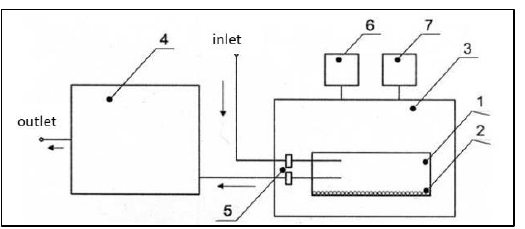
Fig. 2. Diagram of a system for assessing the toxicity of gas mixtures using the BAT-CELL Bio-Ambient-Tests method (1 – sterile sampler, 2 – cell line devoid of culture fluid, 3 – conditioning chamber equipped with pressure (6) and temperature (7) sensors, 4 – aspirating system, 5 – anti- bacterial filters) [12]